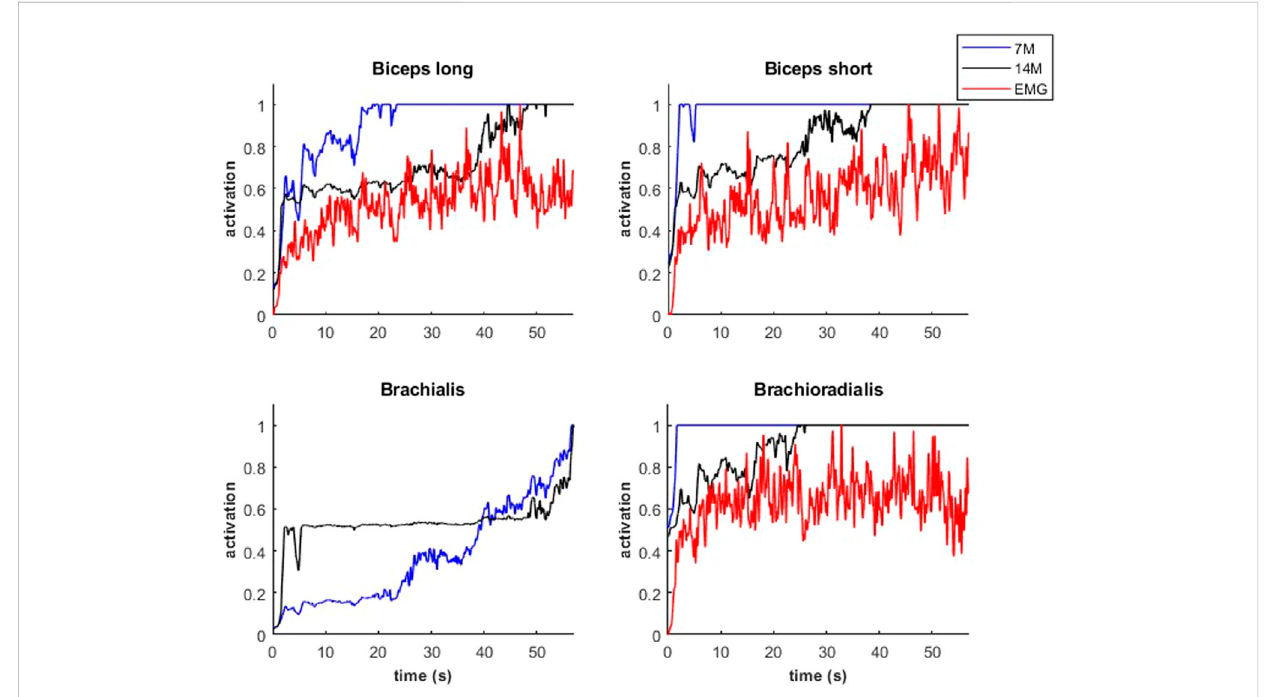
FIGURE 8 Activations of fl exor muscles during the submaximal static